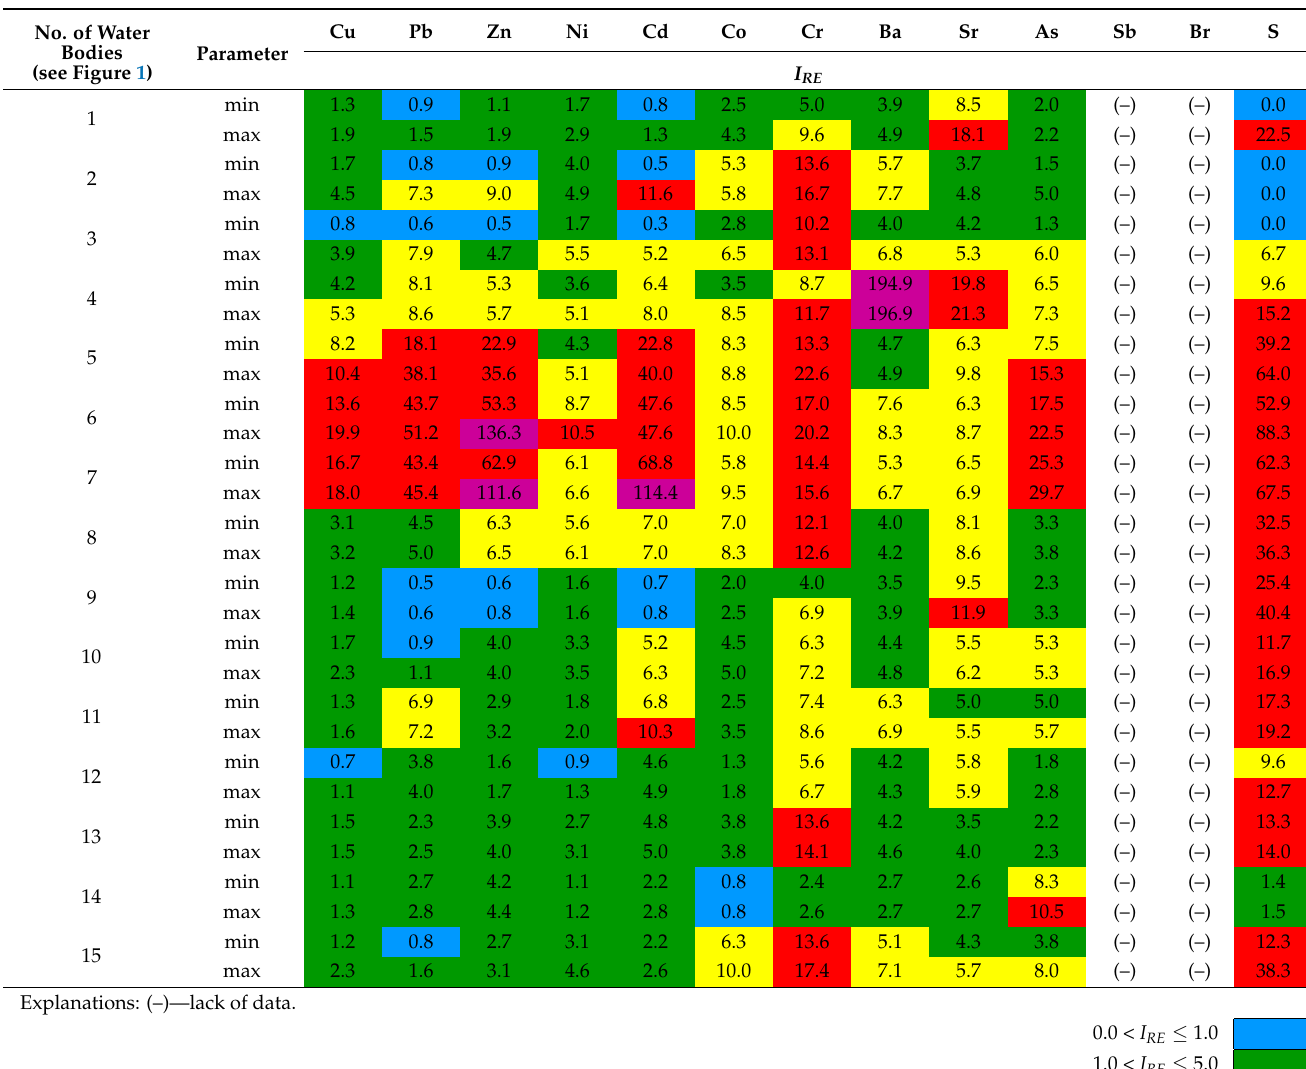
Table 5. Ranges of the values found as multiples of the regional geochemical background for metals and non-metals in the bottom sediments of water bodies used for recreational purposes in the Silesian Upland and its